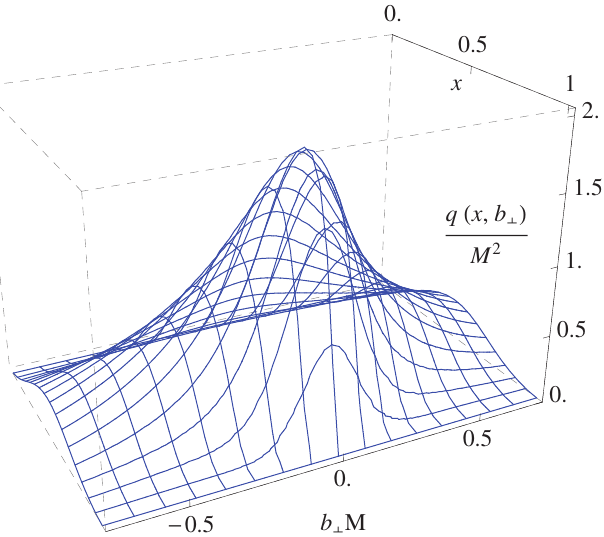
Figure 4. 3D picture of a model computation of the pion quark GPD in the impact parameter space. Figure from